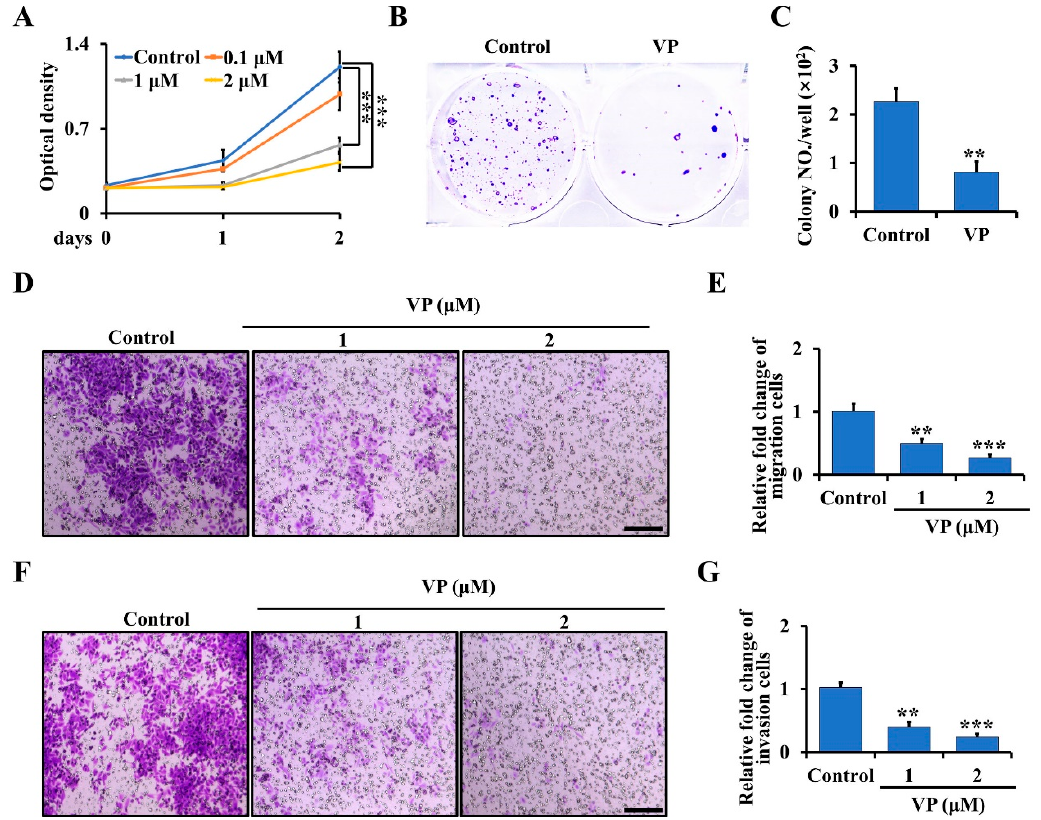
Figure 3. VP inhibits proliferation, migration, and invasion in Trp53/Rb1-mutant Ctsk-expressing osteosarcoma cells. ( A ) The primary osteosarcoma cells from Ctsk-Cre;Trp53 f/f /Rb1 f/f mice were collected and seeded in a 96-well plate. After being cultured for the indicated time, the cell proliferation was determined by WST-1 Cell Proliferation Assay Kit. ( B,C ) Soft agar assay ( B ). The primary osteosarcoma cells from Ctsk-Cre;Trp53 f/f /Rb1 f/f mice were incubated with 0 or 2 µM VP for 3 weeks, and then the colony numbers were counted ( C ). ( D , E ) The primary osteosarcoma cells were isolated from Ctsk-Cre;Trp53 f/f /Rb1 f/f mice, and treated with indicated doses of VP in transwell plates. After incubation for 48 h, the migrated cells were stained by crystal violet and viewed under microscope ( D ). Scale bars, 100 µm. The corresponding quantification was identified ( E ). ( F , G ) Cell invasion and quantification as indicated. Scale bars, 100 µm. Error bars were the means ± SEM from three independent experiments. ** p < 0.01, *** p < 0.001.